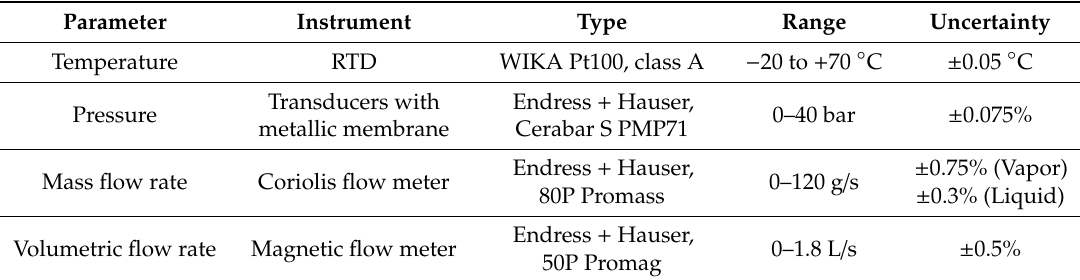
Table 1. Measured parameters and